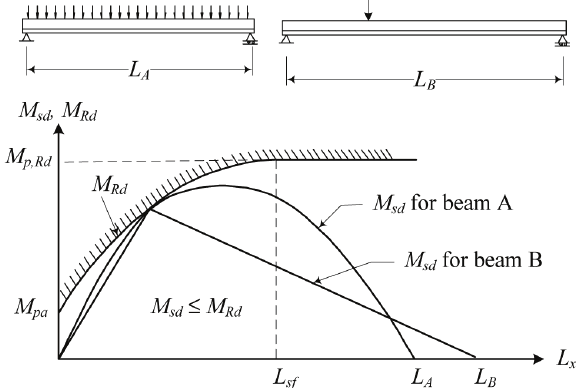
Fig. 3. Partial interaction moment curve